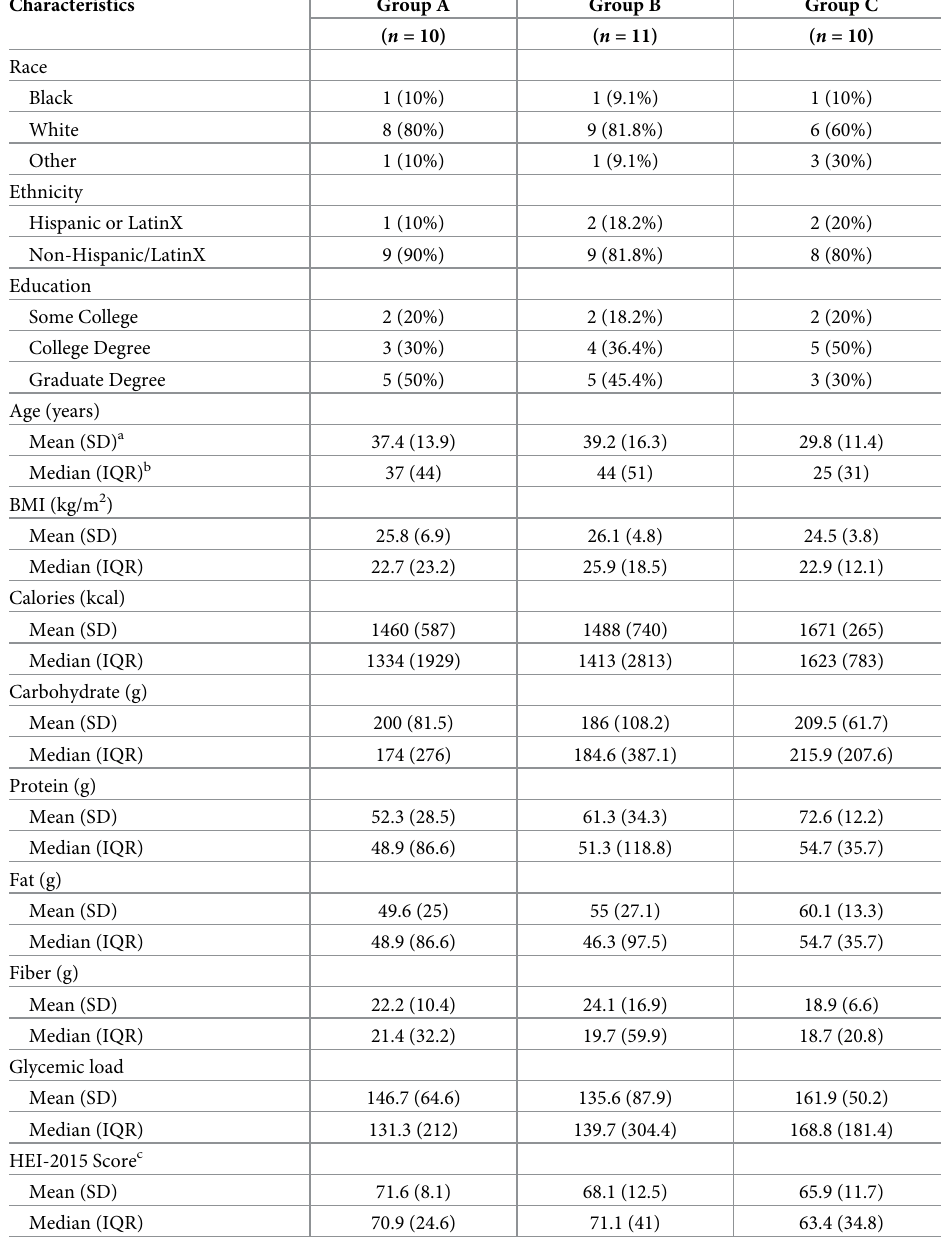
Table 1. Demographic and dietary characteristics of study participants ( n = 31).